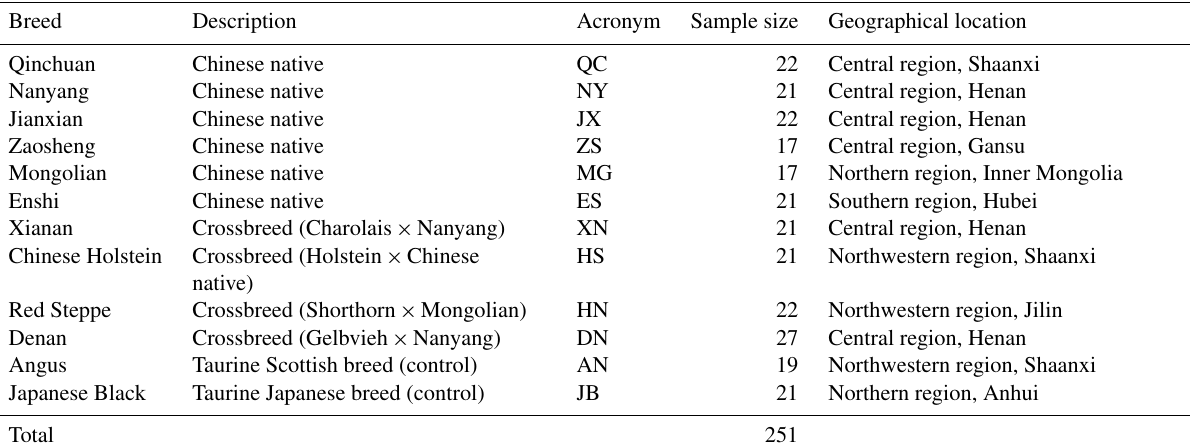
The mean haplotype diversity of the 10 Chinese